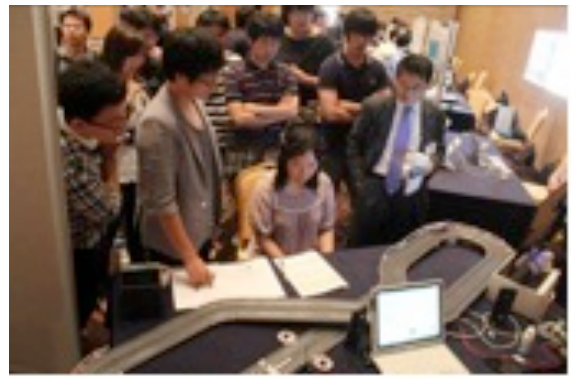
Figure 1. BCI Game using Brain Information